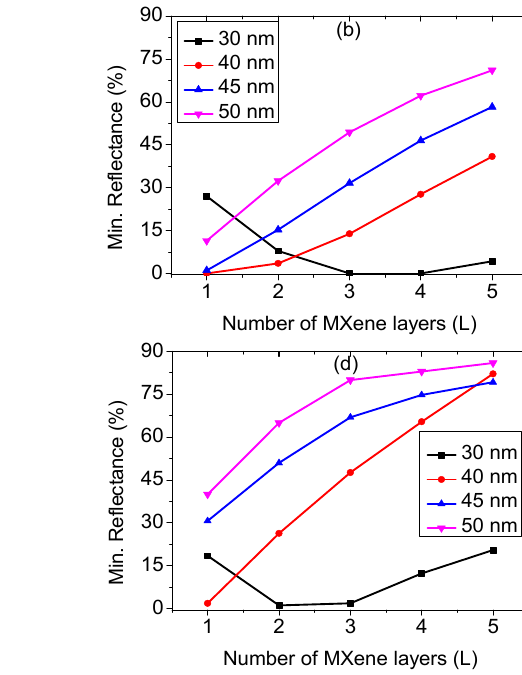
various thicknesses of Ag at Si thickness of ( a ) 1, ( b ) 2, ( c ) 3, and ( d ) 4 nm.